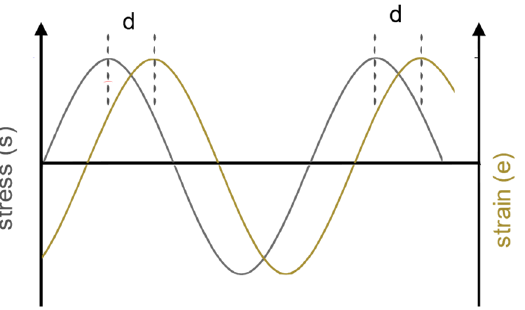
Figure 3. Temporal offset of stress and strain diagram of a viscoelastic material under dynamic load. Adapted from [23], Elsevier, 2021.